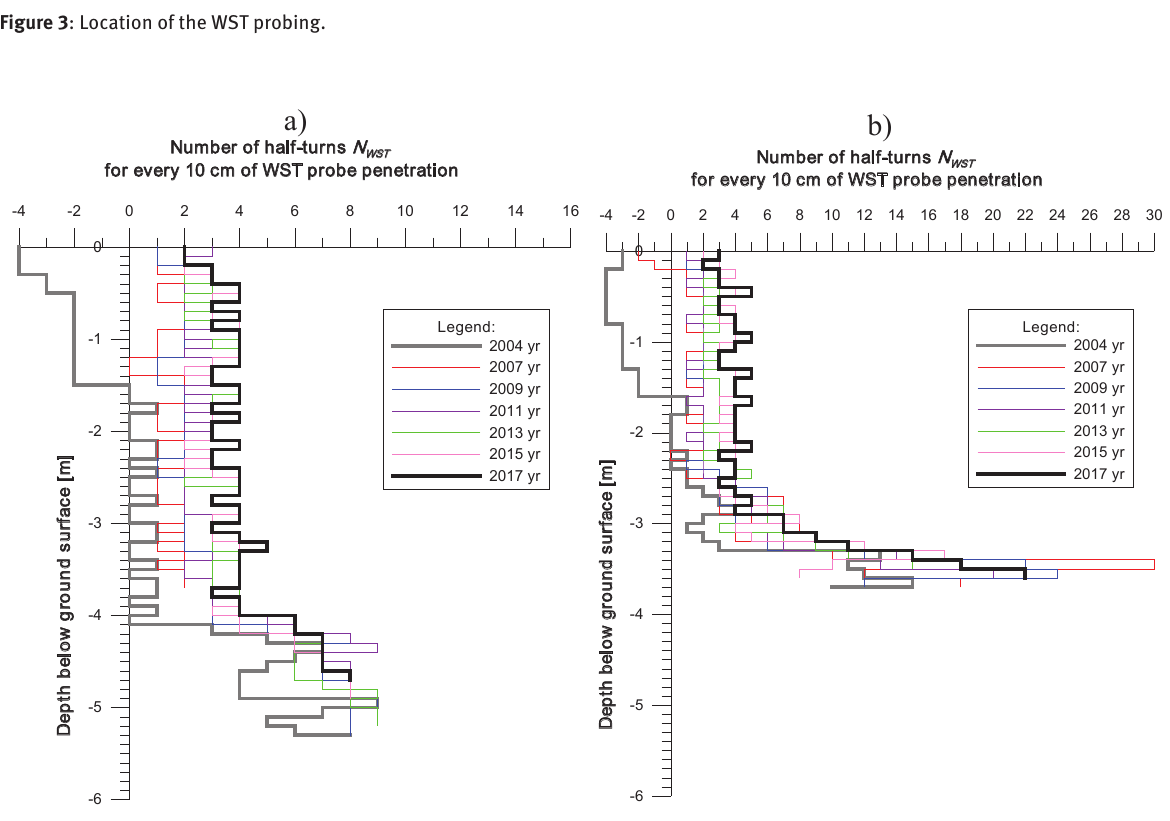
Fig. 4. WST probing results between counterforts P1 and P2